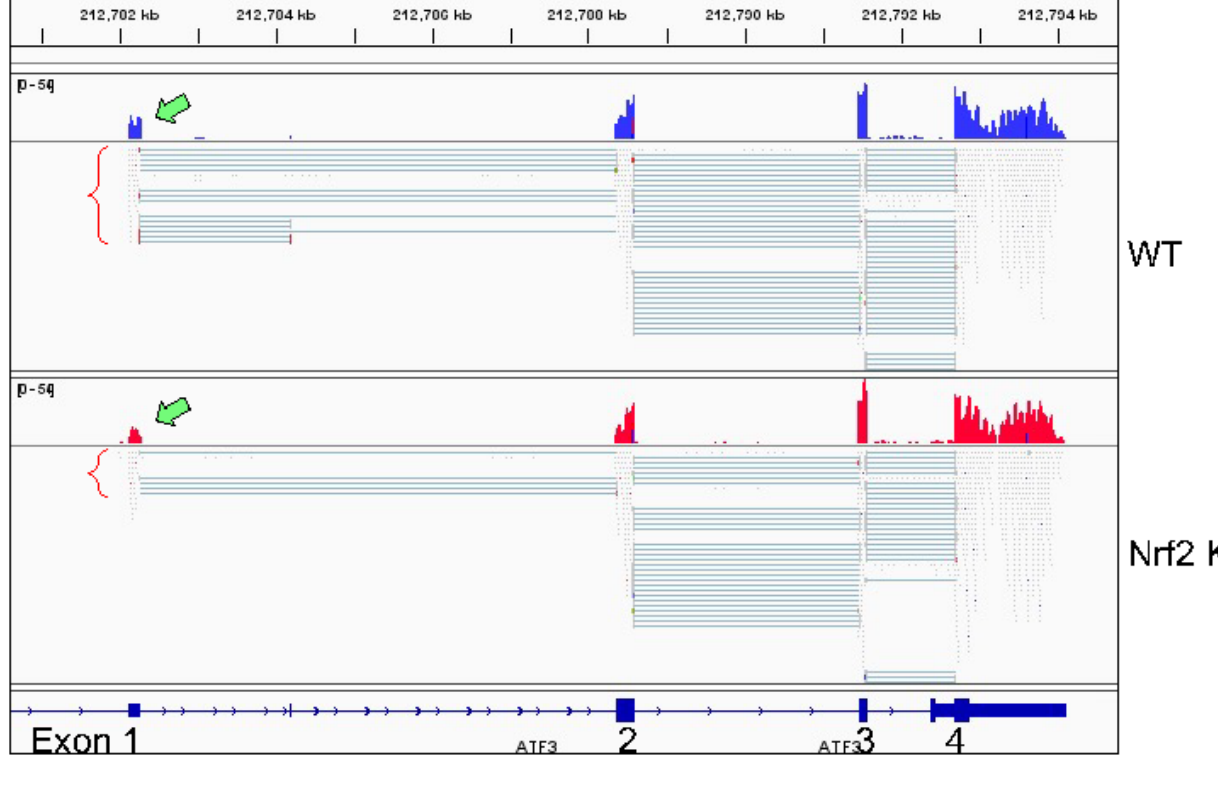
Figure 5. Knockout of Nrf2 reduced ATF3 expression. RNA-seq spectrums were shown for the WT and Nrf2 KO cells. The readout of exon1 of ATF3 is pointed by green block arrows. Our RNA-seq experiment is partially consistent with the findings described